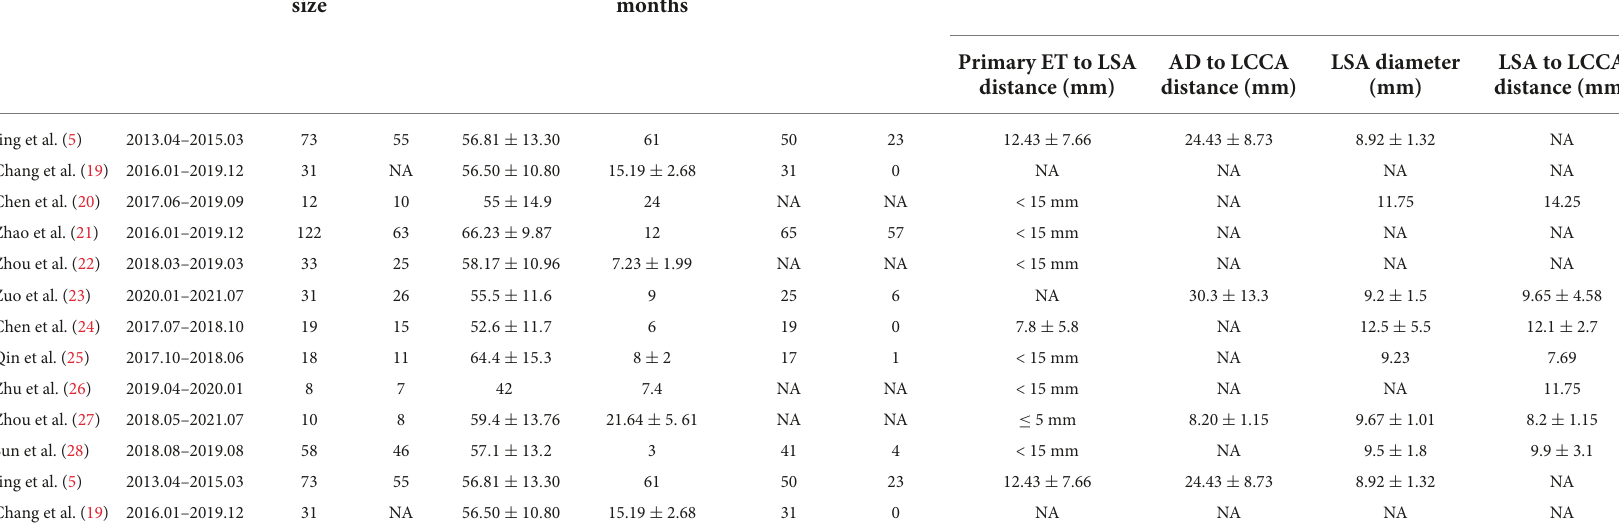
TABLE 1 Baseline patient characteristics and details of aortic